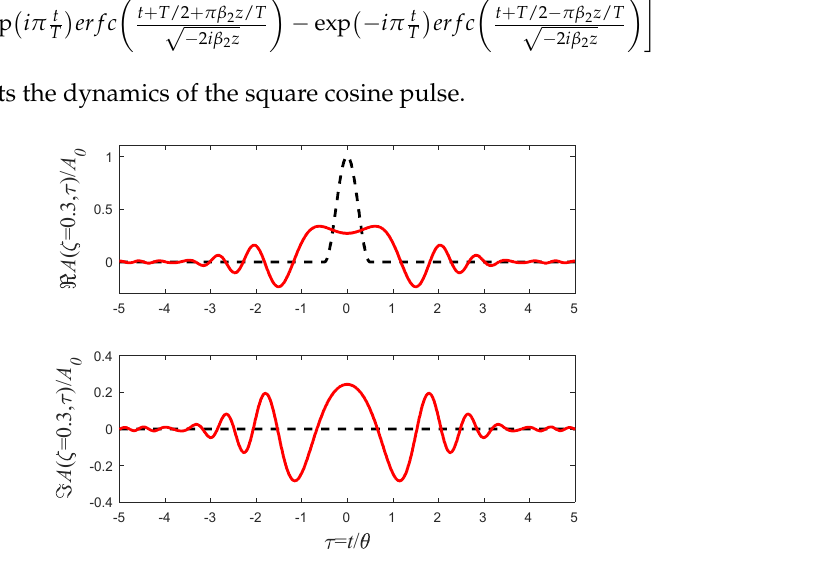
Figure 14. Similar to Figure 12, but for the square cosine pulse (Equation (42)).